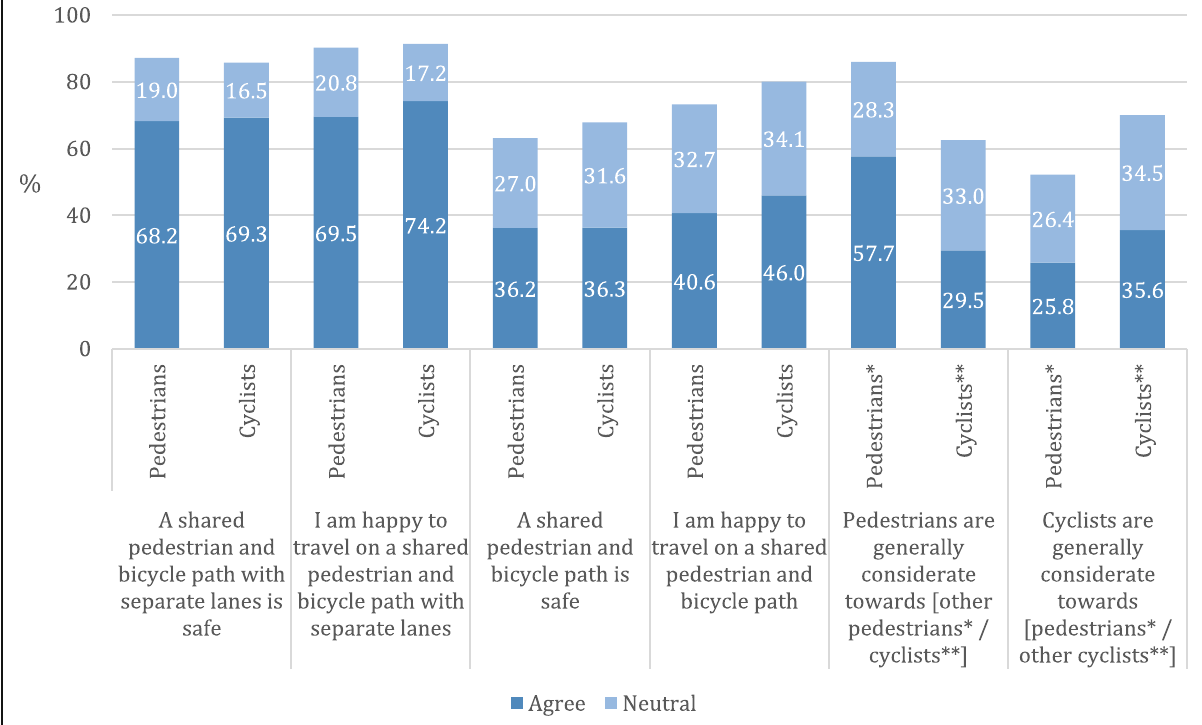
Fig. 4 Responses to statements concerning sense of safety ( n = 1025 – 1036 per statement for pedestrians and 633 – 643 for